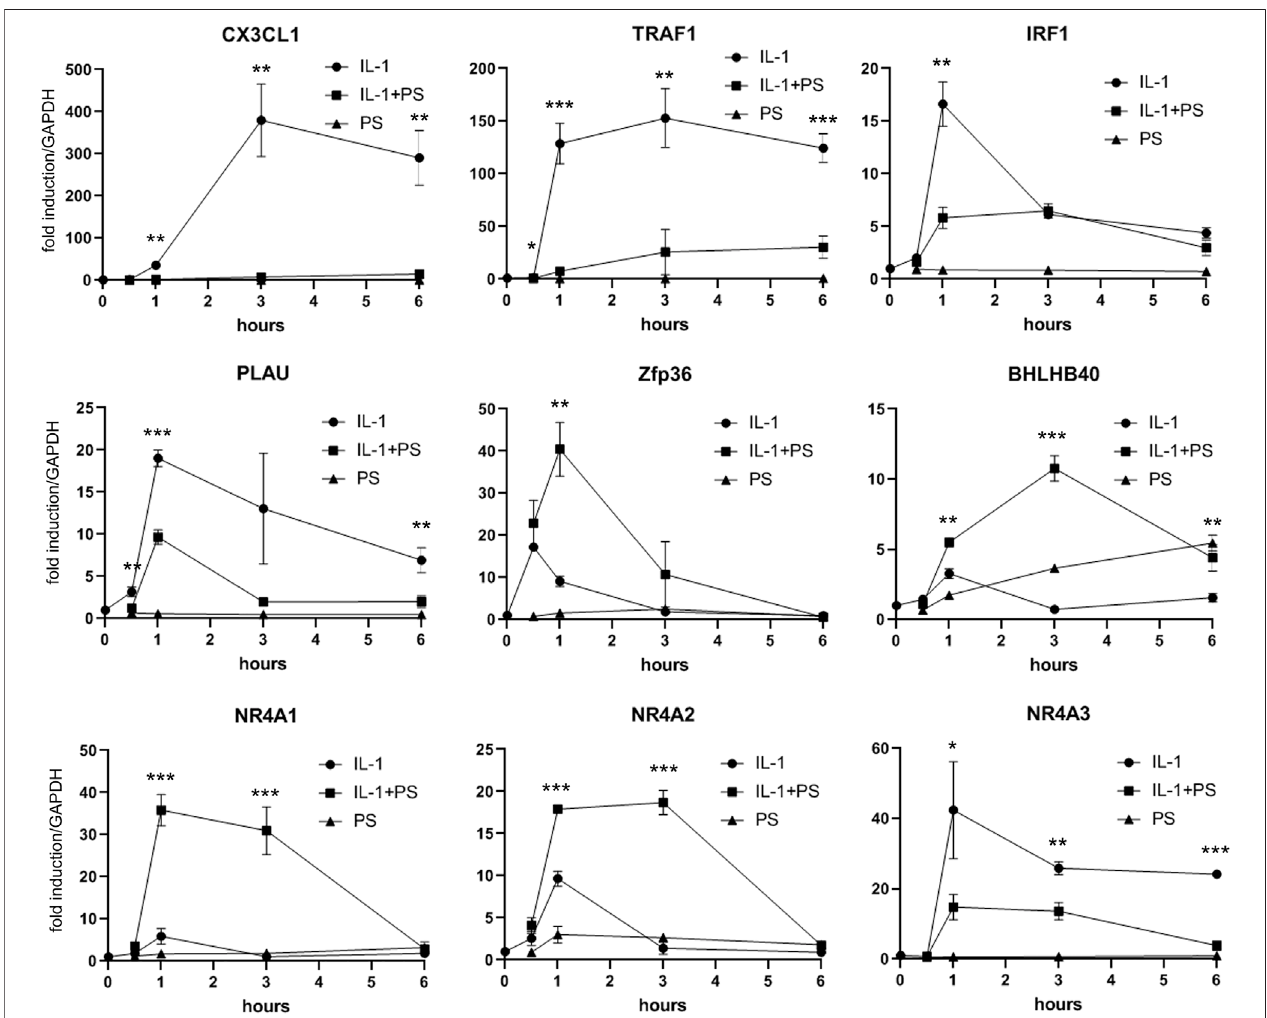
FIGURE 4 | qPCR analysis of selected PS regulated genes. HUVEC were stimulated with 5 ng/ml IL-1 either alone or after pre-treatment for 30 min with 50 μ g/ml PS, and analyzed by qPCR as indicated. *, **, and *** indicate p < 0.05, 0.01, and 0.001, respectively, of IL-1 + PS versus IL-1 alone.